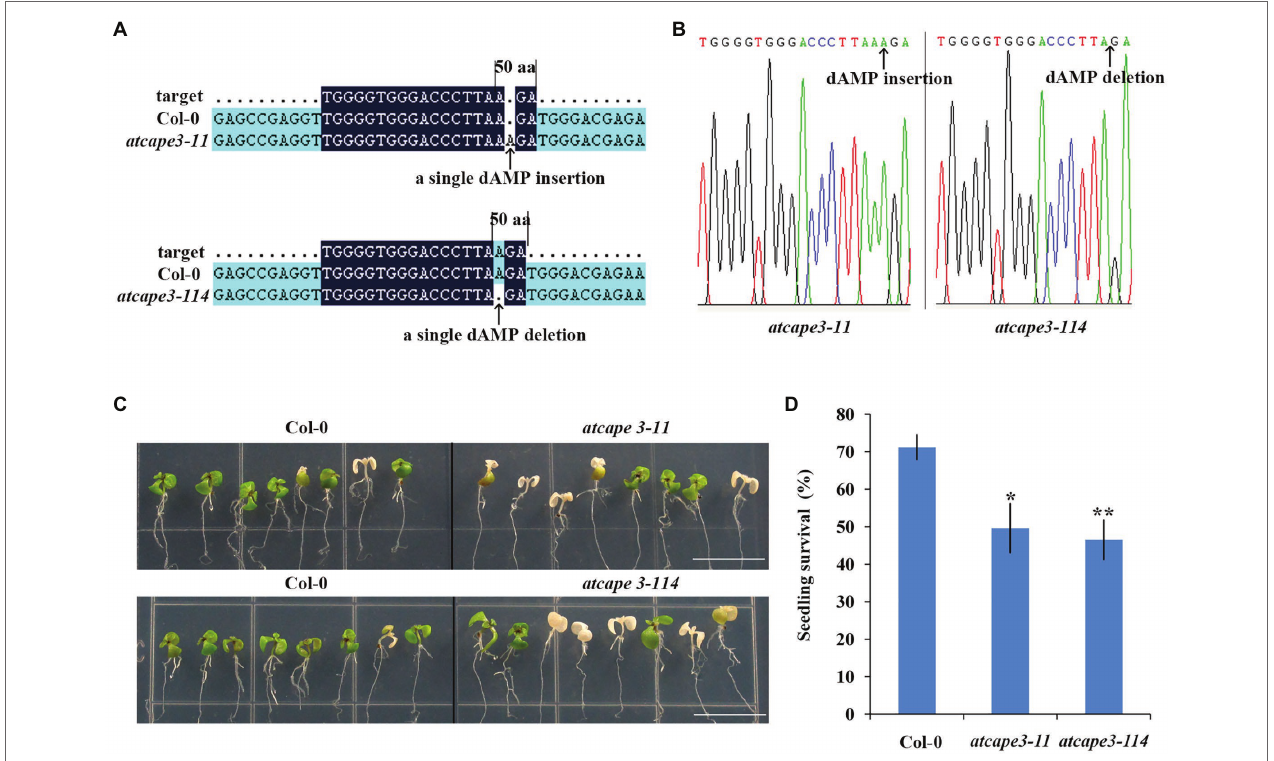
FIGURE 8 | Generation of atcape3 mutants and seedling survival rate. (A) Schematic of the atcape3 mutant insertion ( atcape3-11 ) site and deletion ( atcape3-114 ) site. Arrows point to the insertion site and deletion site. (B) SANGER sequencing chromatography confirming insertion site and deletion site in atcape3 mutants. Arrows point to the insertion site and deletion site. (C) Survival phenotype of Col-0 and atcape3 seedlings under salt treatment. Plants were grown on 1/2 MS medium for 6 days and then transferred onto 1/2 MS medium supplemented with 200 mM NaCl for 5 days. Experiments were repeated three times with similar results. Scale bars = 1 cm. (D) Survival rate of seedlings shown in (C) . At least 30 seedlings were examined per replicate ( n = 3 replicates). * p < 0.05 and ** p < 0.01 (Student’s t -test) indicate significant differences between mutants and Col-0 plants. Error bars indicate the standard error for the average of three independent